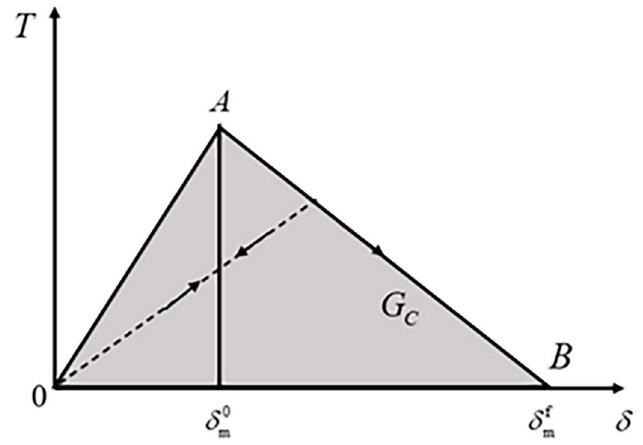
Figure 2. Bilinear traction-separation curve.